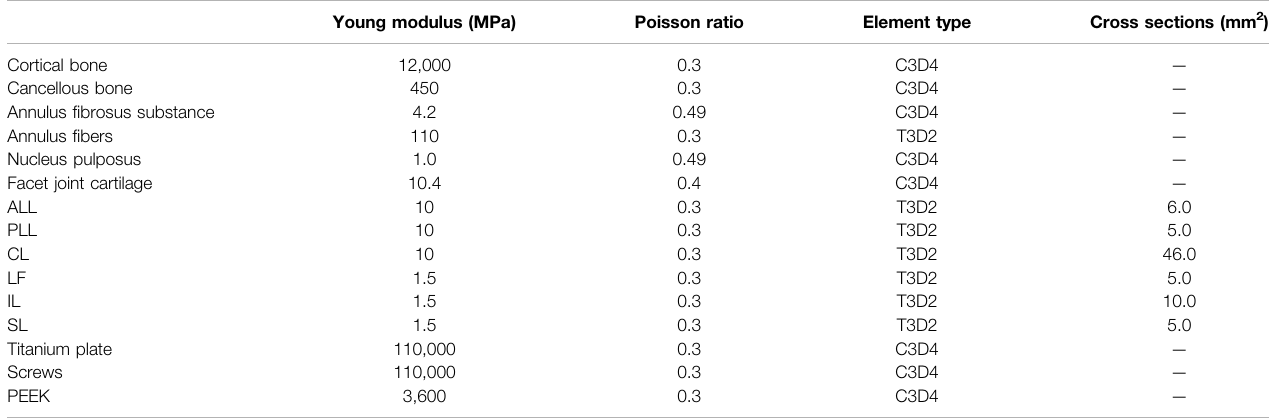
TABLE 1 | Material properties and mesh types of the cervical fi nite element model.